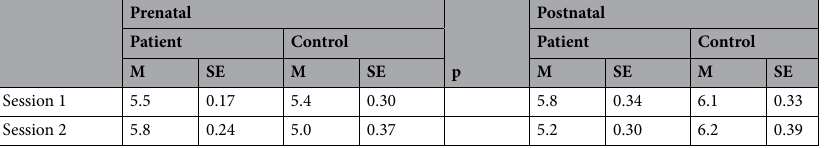
Table 3. Mean (M) and standard error (SE) of odour detection threshold (score range 2–9) of the patient and control groups at different perinatal